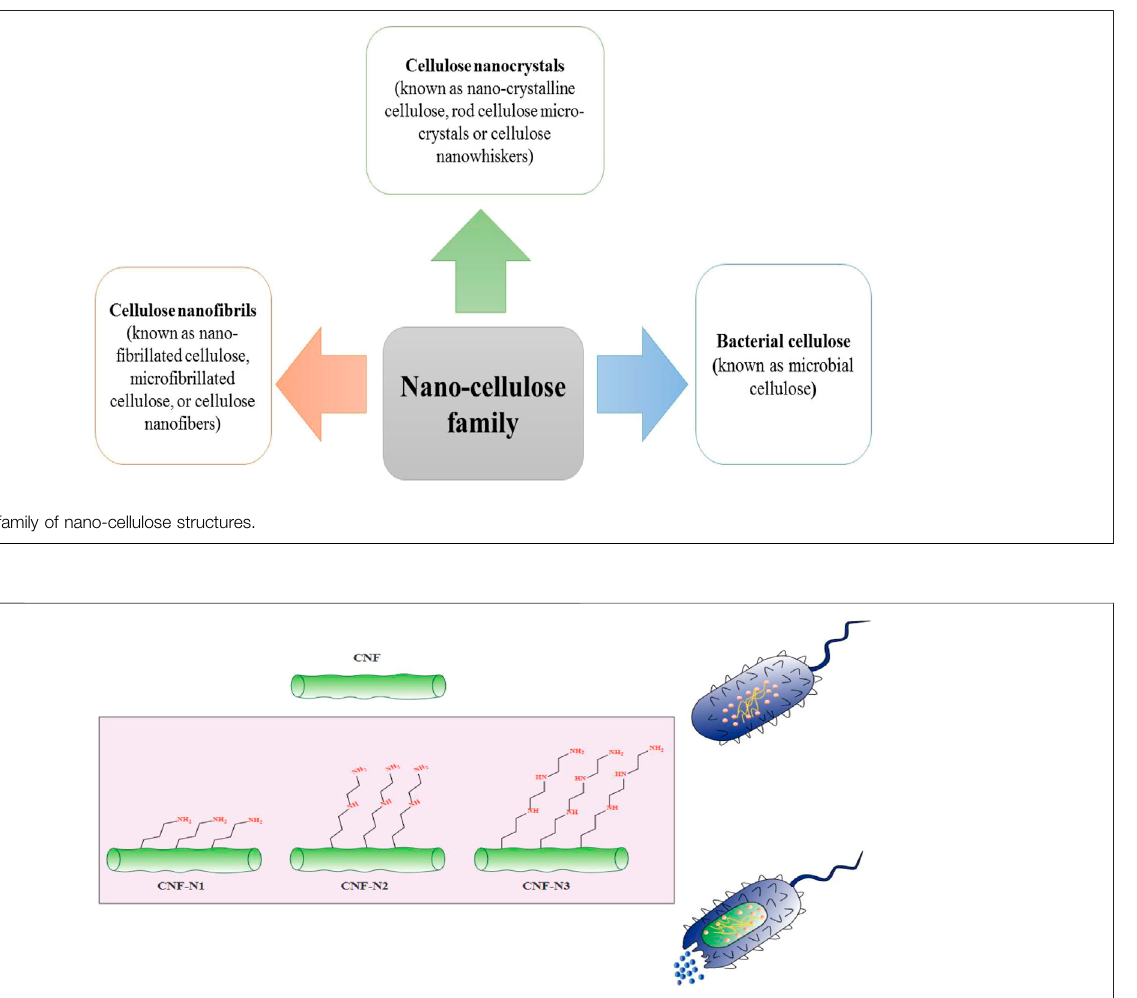
Frontiers in Bioengineering and Biotechnology |